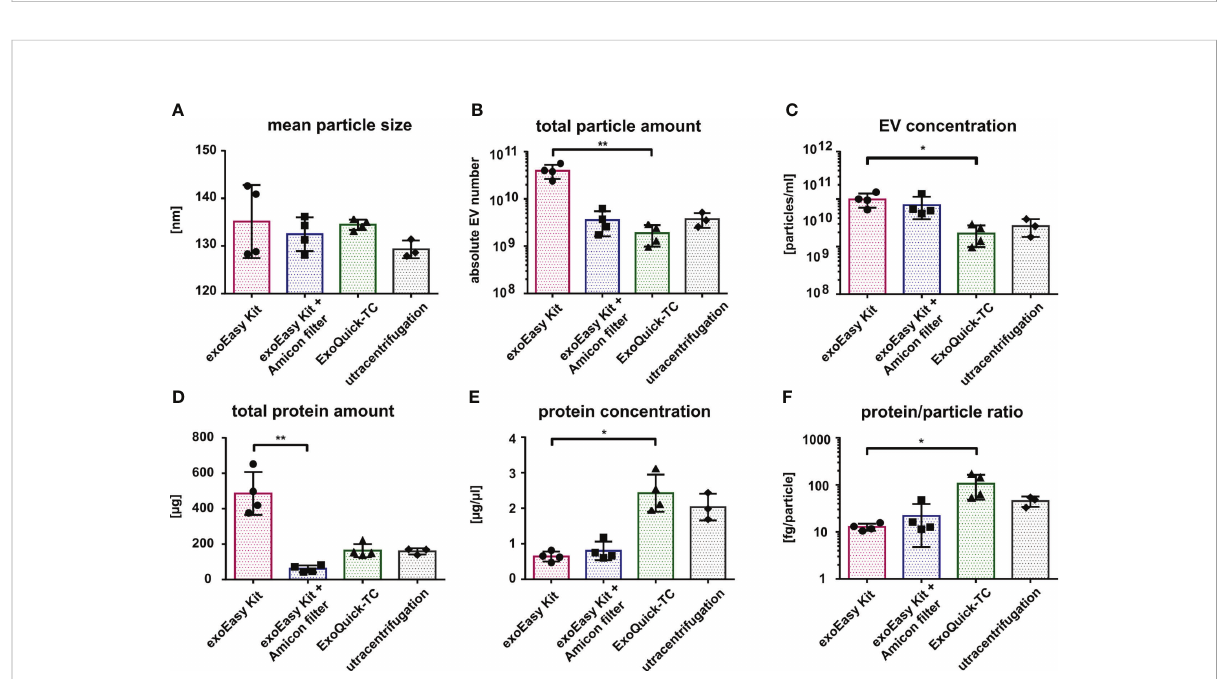
FIGURE 3 Characterizationof MOLM-13-derivedEVsaccordingtodifferent isolationmethods.ComparisonofMOLM-13-derived EVsisolatedwithdifferentisolation methods usingnanoparticle trackinganalysis(NTA) (A – C) andproteinmeasurement (D,E) . Histogramsrepresentingthe meanparticlesize (A) ,total particle amount (B) , andparticleconcentration (C) afterexoEasyKit(n=4), exoEasyKit+Amicon fi ltration(n=4), ExoQuick-TC(n=4), andUC(n=3)isolation procedures.Histogramsrepresentingtotalproteinamount (D) andproteinconcentration (E) afterexoEasyKit(n=4), exoEasyKit+Amicon fi ltration(n= 4), ExoQuick-TC(n=4),and UC(n=3)isolationprocedures. Histogramsrepresentingthe protein/particle ratiocalculatedbydividingthetotal protein amountby thetotal particlenumberfromeachpaired sample (F) (n=3forUC,n=4 forotherisolationmethods). * p <0.05,** p